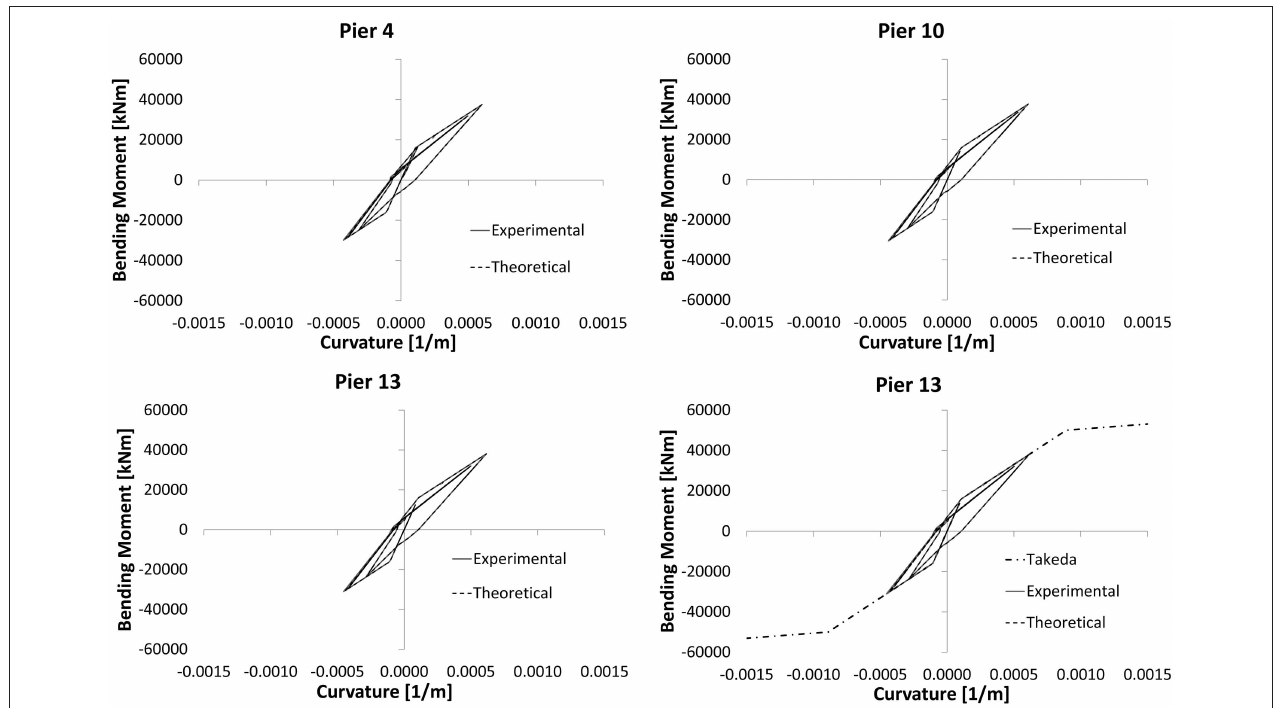
FIGURE 11 | Longitudinal moment vs. curvature diagrams at the base of the piers: comparison between experimental and numerical